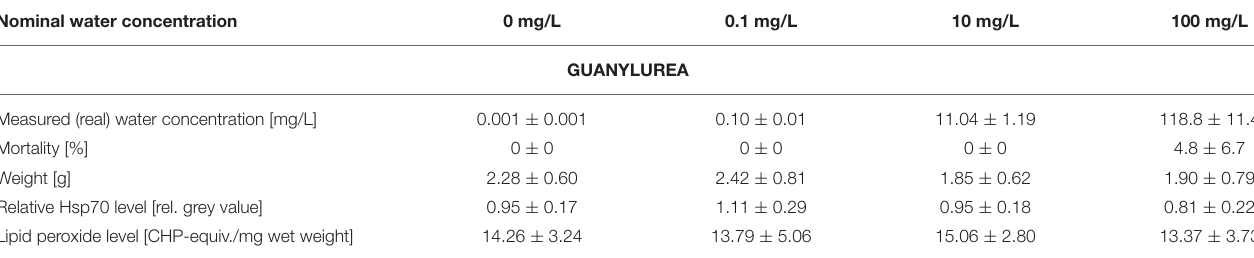
All parameters are provided as arithmetic mean ± standard